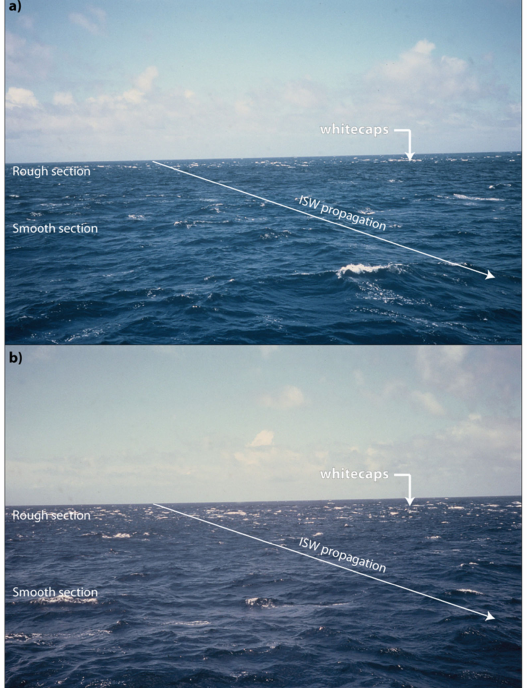
Figure 1. Photographs taken from the Research Vessel Charles Darwin showing sea surface mani- festations of a large-amplitude ISW advancing towards the ship in the central region of the Bay of Biscay, which includes surface wave breaking (i.e., whitecaps). Note that both panels ( a , b ) are just a few minutes apart, and wave breaking has moved towards the ship from ( a ) to ( b ). Courtesy: Adrian L. New from the National Oceanography Centre,